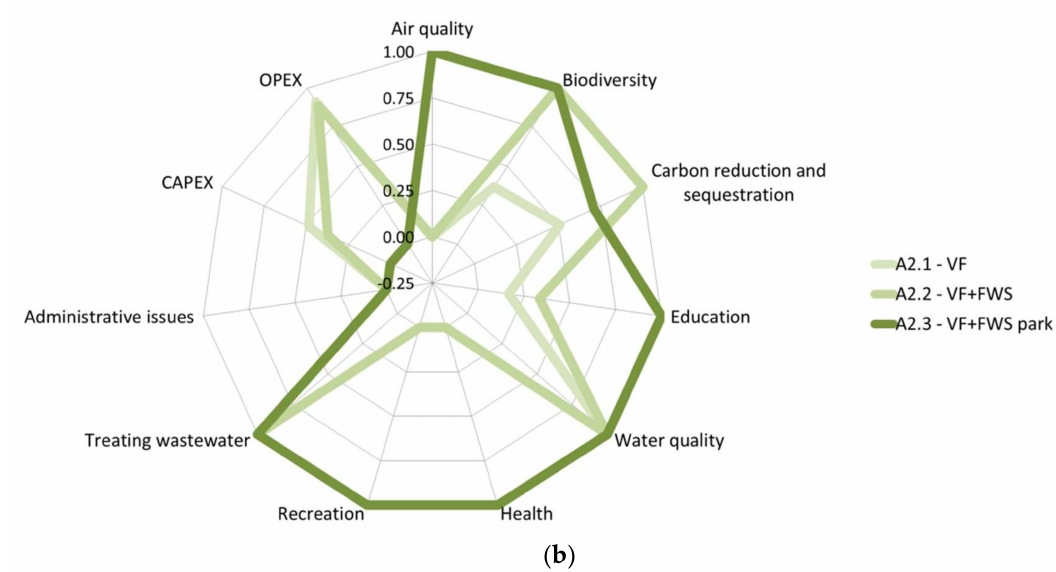
Figure 2. Graphical representation for the evaluation matrix of the MCA (after criteria normalizan. for the two groups of alternatives: ( a ) Grey infrastructure; A1.1: primary treatment only (primary only). A1.2: first flush tank, minimum size (FFT—min). A1.3: first flush tank, maximum (FFT—max). ( b ) Green infrastructure. A2.1: vertical subsurface flow CW (VF). A2.2, vertical subsurface flow plus free water surface CW (VF + FWS). A2.3, vertical subsurface flow plus free water surface CW in an urban park (VF + FWS park).